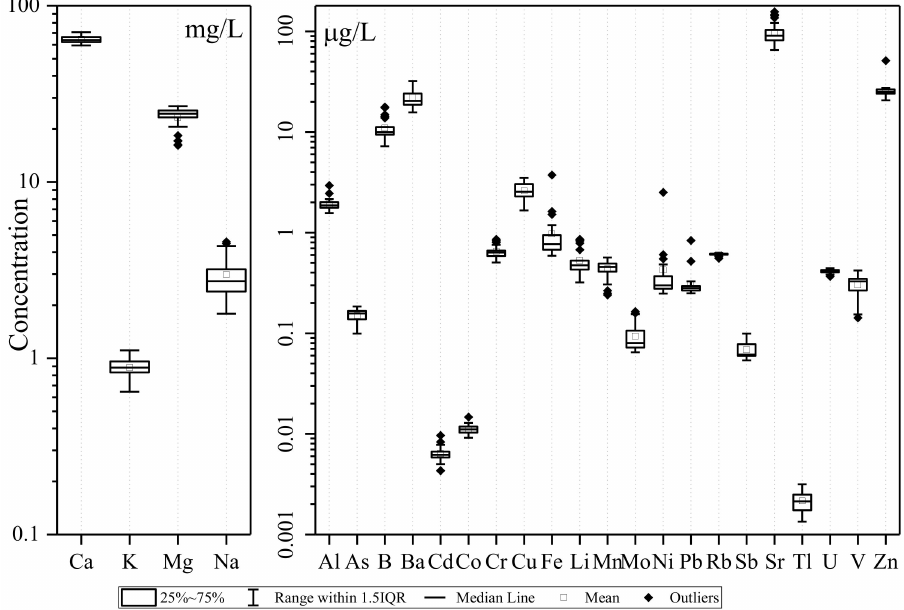
Figure 3. Boxplots of element concentrations (major and trace elements) in all tap water